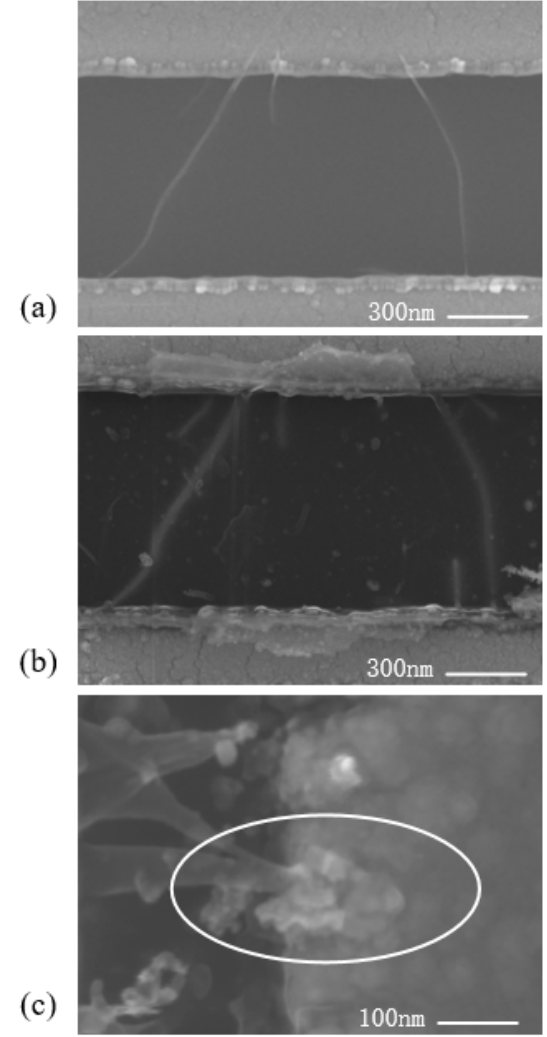
Figure 3. ( a , b ) SEM image before laser irradiation at the same position and after irradiation with a laser having an energy density of 13.810mJ/cm 2 . It can be observed that the ends of the SWCNT can be clearly seen on the surface of the electrodes before irradiation, and the end of the SWCNTs is hardly visible after irradiation. At this time, SWCNTs are connected to the Ni electrodes; ( c ) A high-resolution SEM image of the SWCNTs connected to the electrode, the SWCNTs embedded in the electrode are marked.